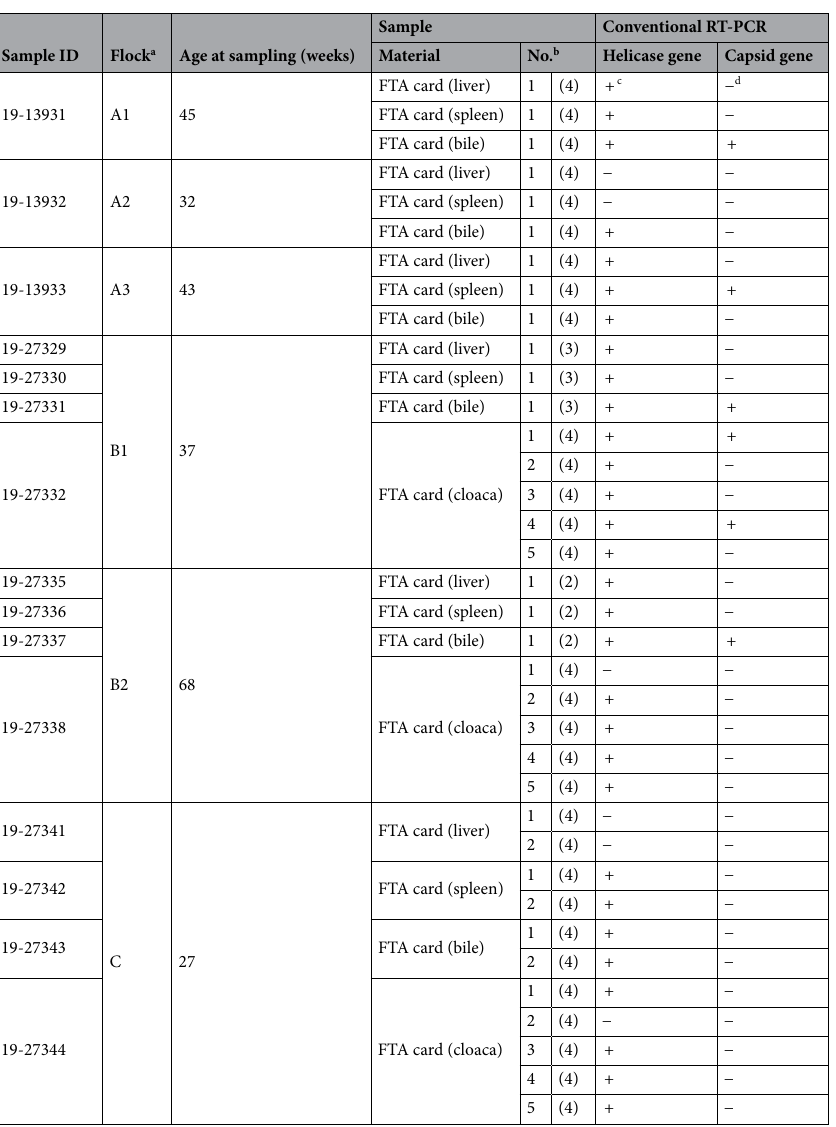
Table 1. List of samples from Polish chicken flocks suffering from HS syndrome that were investigated for aHEV RNA by conventional RT-PCR, and corresponding results. a Flocks with the same letter belong to the same farm. b Sample number (number of corresponding sampled birds). c Positive. d